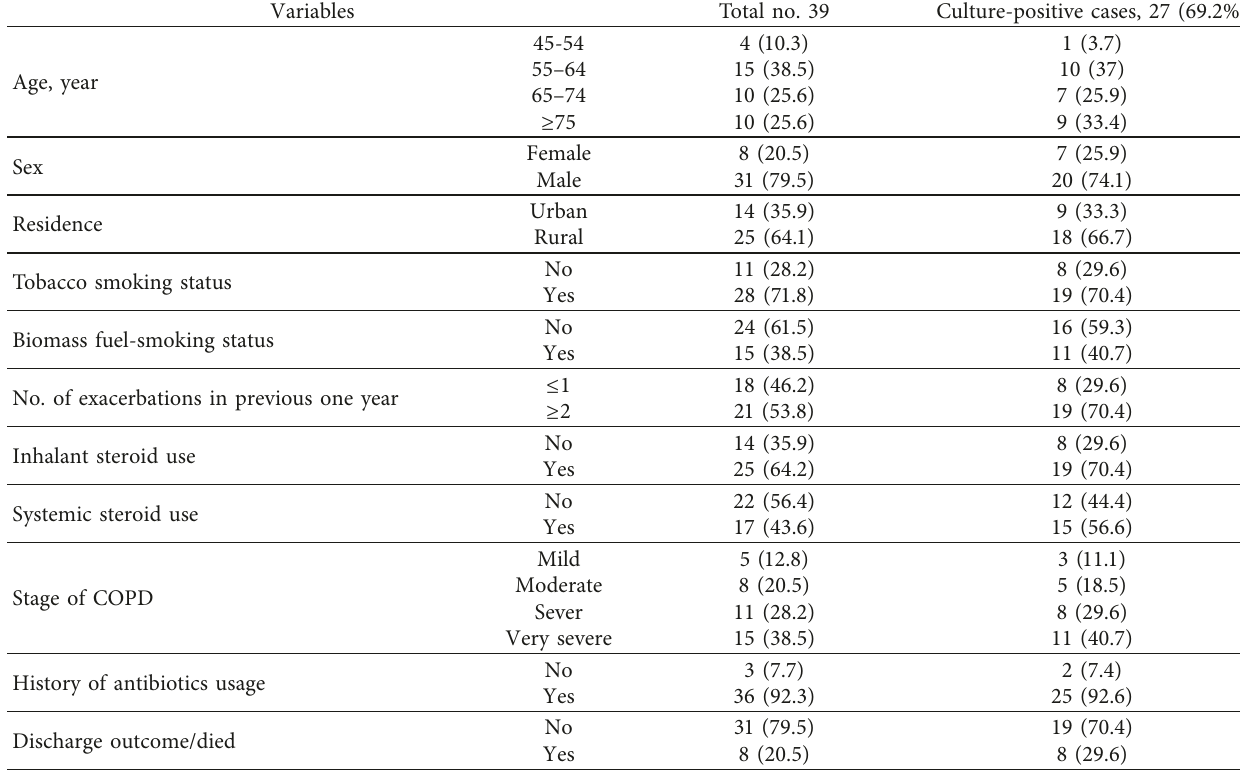
Table 2: Demographic and related clinical characteristics of patients with AECOPD at JUMC, southwest Ethiopia, 2019. ( n � 39) in JUMC.